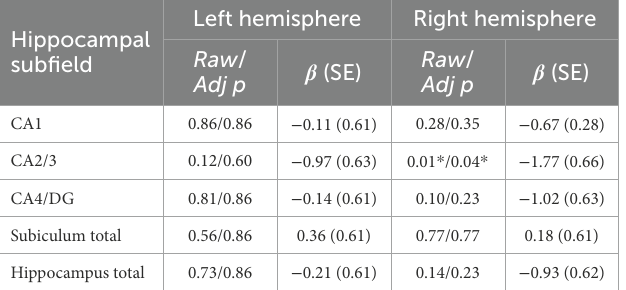
TABLE 3B Group effect in volumes between TRD patients and healthy controls, adjusting for age and sex using proportional odds ordinal logistic regression model.